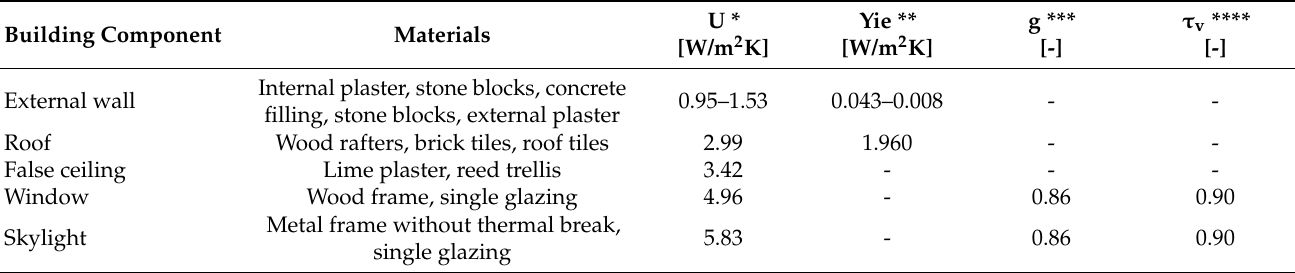
Table 4. Thermal and optical properties of the existing building envelope of La